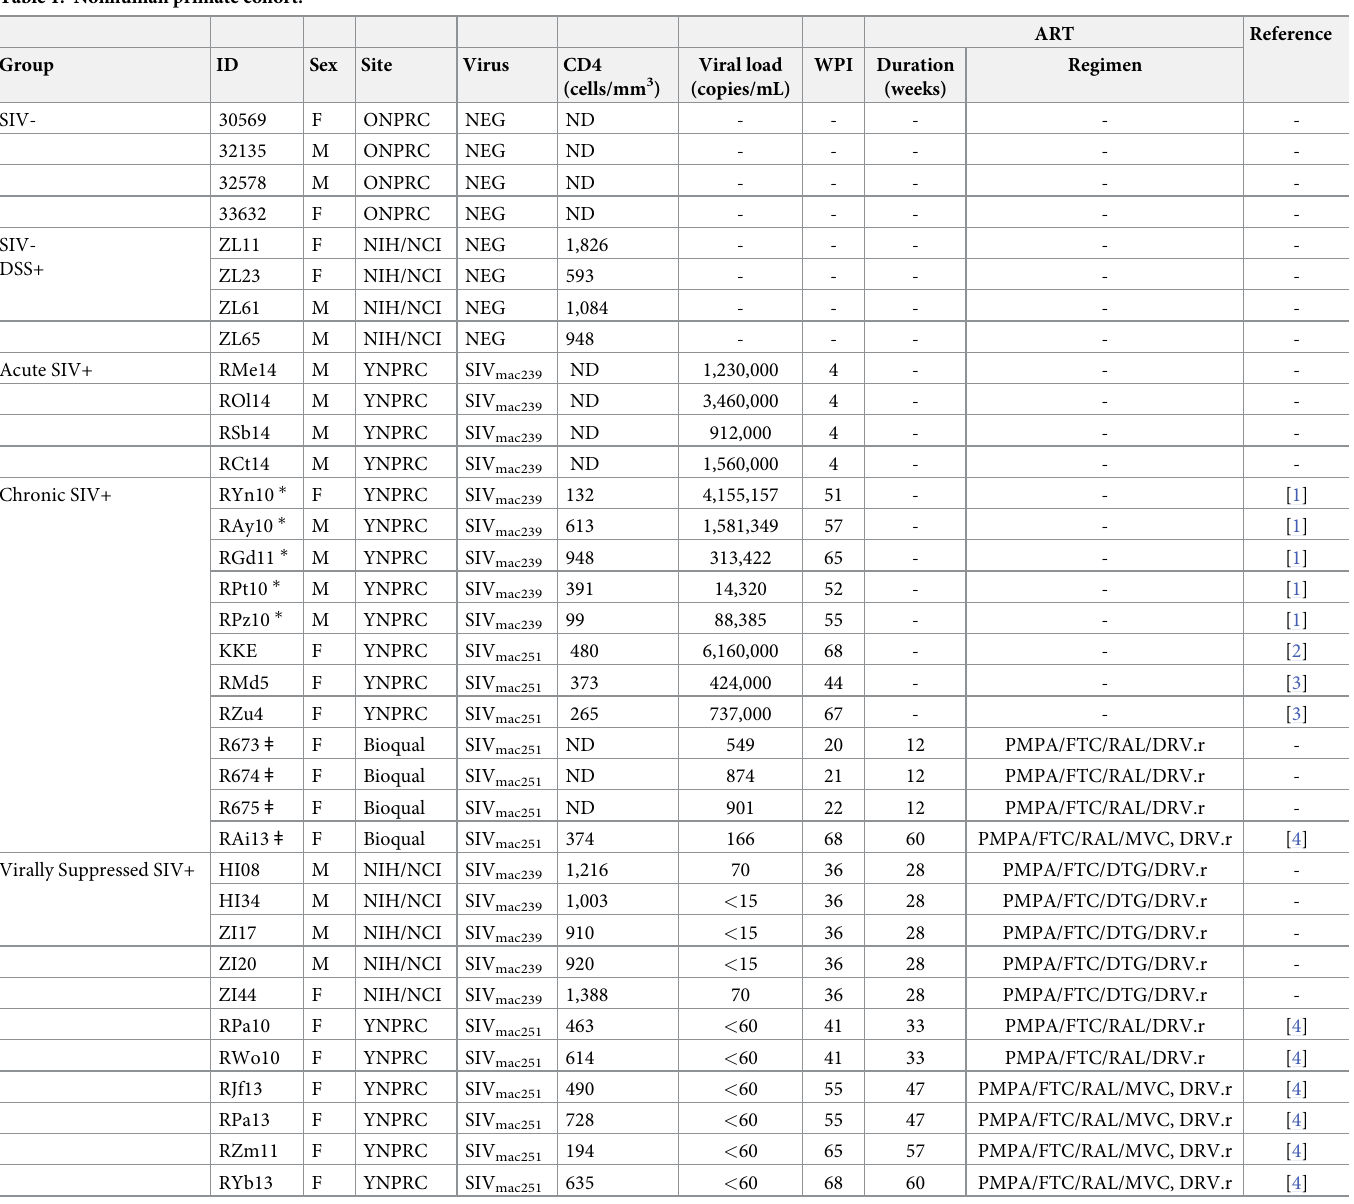
Table 1. Nonhuman primate